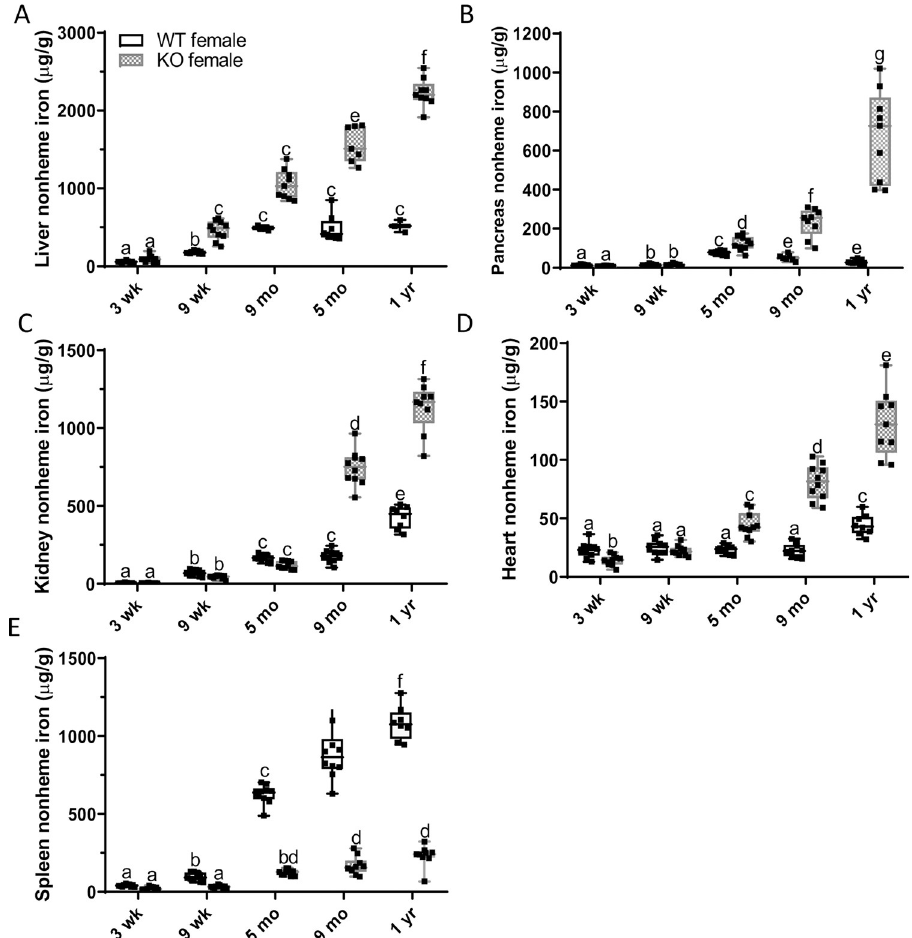
Fig 8. Multi-visceral iron loading and spleen iron depletion over time in female rats. To characterize the chronology of iron loading, tissue nonheme iron concentrations were determined at different ages in female WT and Hamp -/- rats. Shown are nonheme iron levels in the liver ( A ),pancreas ( B ), kidney ( C ), heart ( D ) and spleen ( E ).Data are presented as box plots for n = 9–10 rats per group and were analyzed by 2-way ANOVA followed by Tukey’s multiple comparisons test ( C-E ).Some data were first log-transformed due to unequal variance ( C-E );however, untransformed data are presented for ease of interpretation. Groups labeled with different letters vary significantly ( p � 0.0274). Genotype × Age, p � 0.0001 ( A-E );Genotype, p � 0.0001, Age, p � 0.0001 ( A-E ).